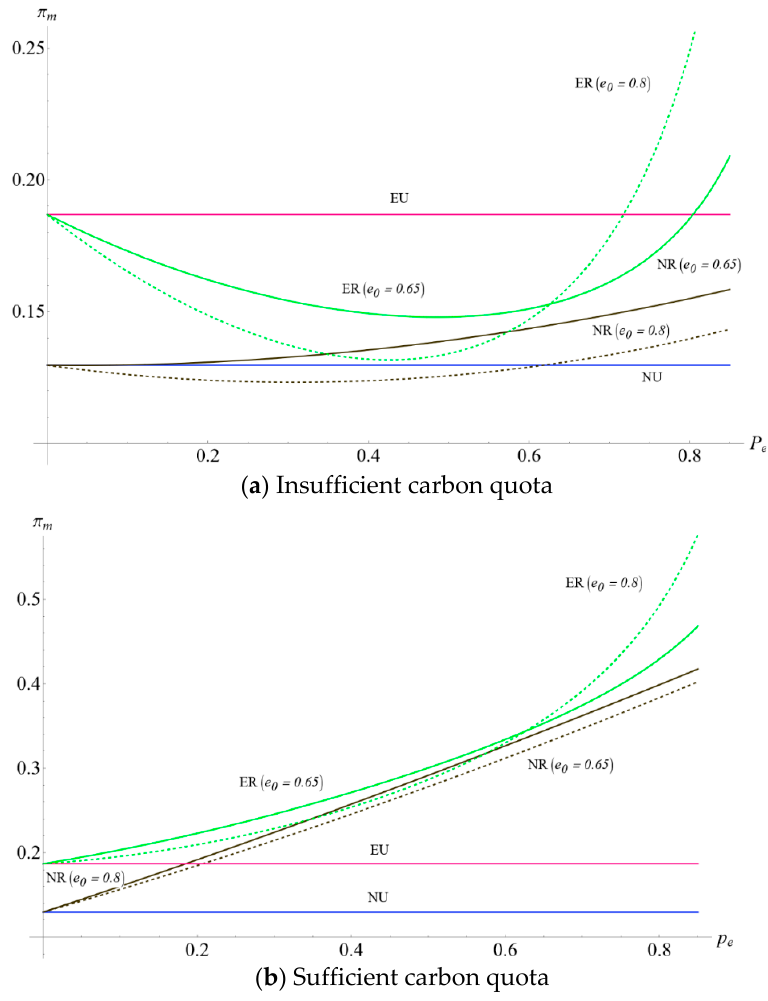
Figure 7. The impact of e 0 and p e on the optimal manufacturer’s profits when the total carbon quota is insufficient ( 𝑆 = 0.15 ) and sufficient ( 𝑆 = 0.45 ).